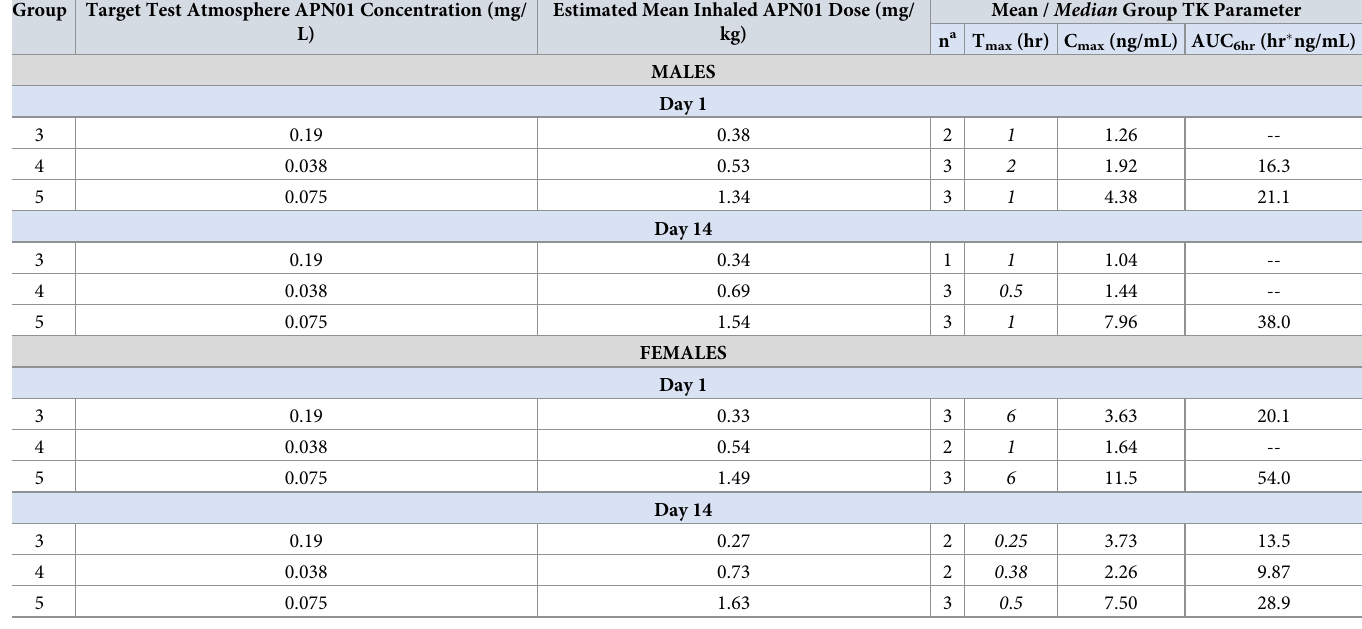
Table 4. Serum levels of inhaled APN01 and toxicokinetic parameters. Dog serum samples were analyzed for levels of APN01 using ELISA. At scheduled blood sam- pling times (Days 1 and 14), serum was sampled from individual animals in Groups 3–5 and subsequently used to model toxicokinetic (TK) parameters. Reported TK parameters are: time at which maximum concentration was observed (T max ), maximum concentration observed (C max ), and area under the concentration curve at six hours (AUC 6hr ). Terminal phase parameters [e.g., T 1/2 ] could not be calculated reliably for any of the profiles due to a lack of amenable data in the terminal phase of the profiles. Data for males and females are shown. Group Target Test Atmosphere APN01 Concentration (mg/